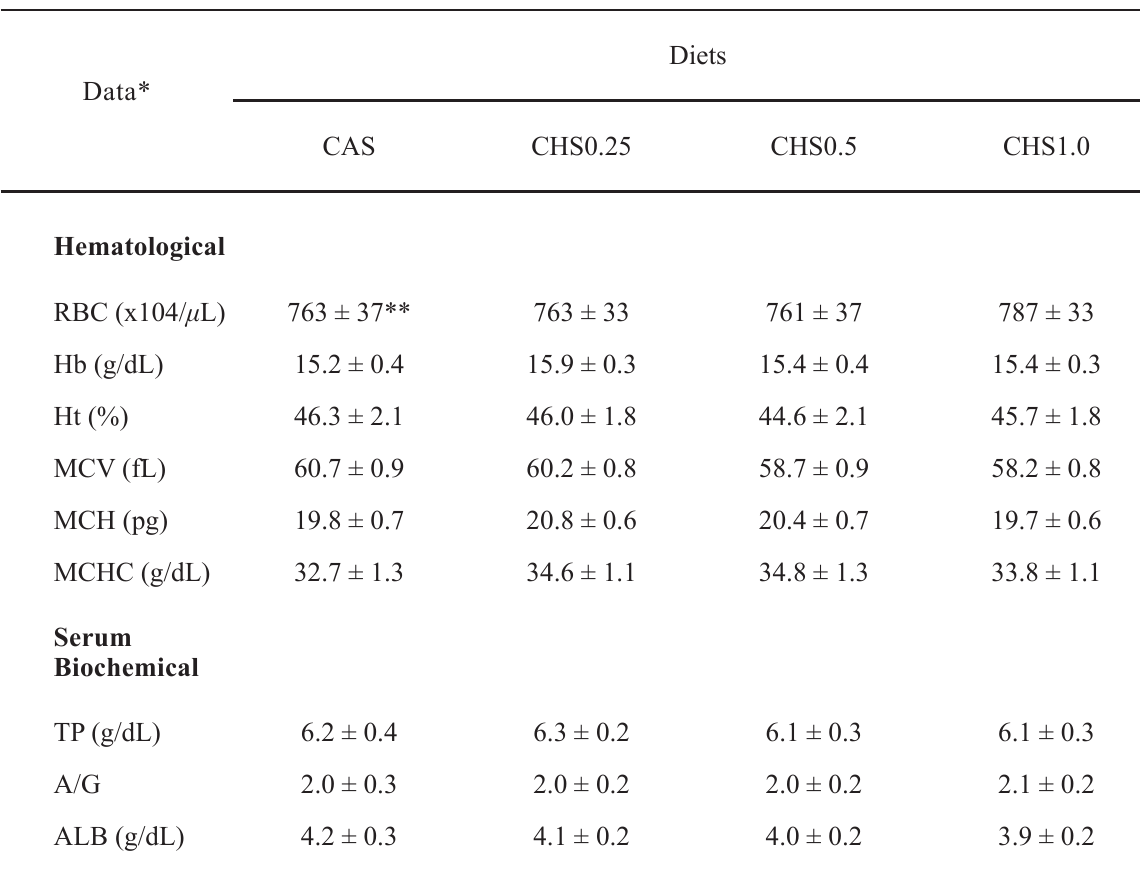
Table II. Hematological and serum biochemical data of rats fed on r-chagasin diets (CHS0.25, CHS0.5 and CHS1.0, corresponding to